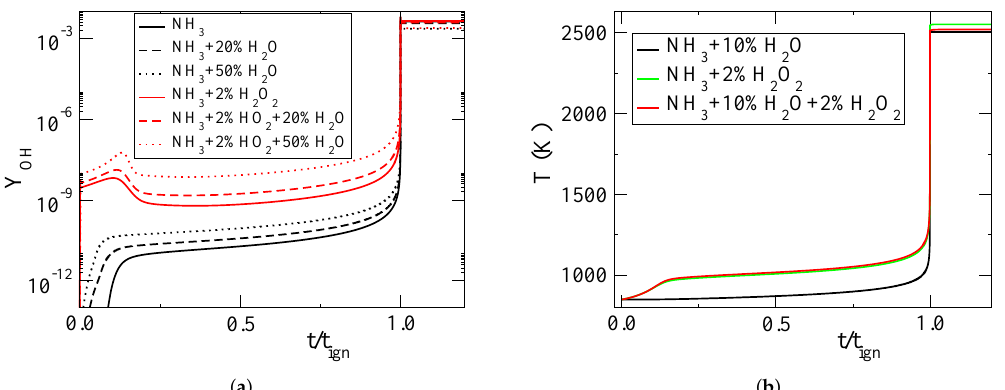
( b ) Figure 6. ( a ) Evolution of OH mass fraction against scaled time (t/t ign ), when considering NH 3 -2%H 2 O 2 mixture with various H 2 O molar percentages (0% denoted by solid lines, 20% denoted by dashed lines and 50% denoted by dotted lines), ( b ) Temperature evolution against scaled time (t/t ign ) for NH 3 -10%H 2 O, NH 3 -2%H 2 O 2 and NH 3 -10%H 2 O-2%H 2 O 2